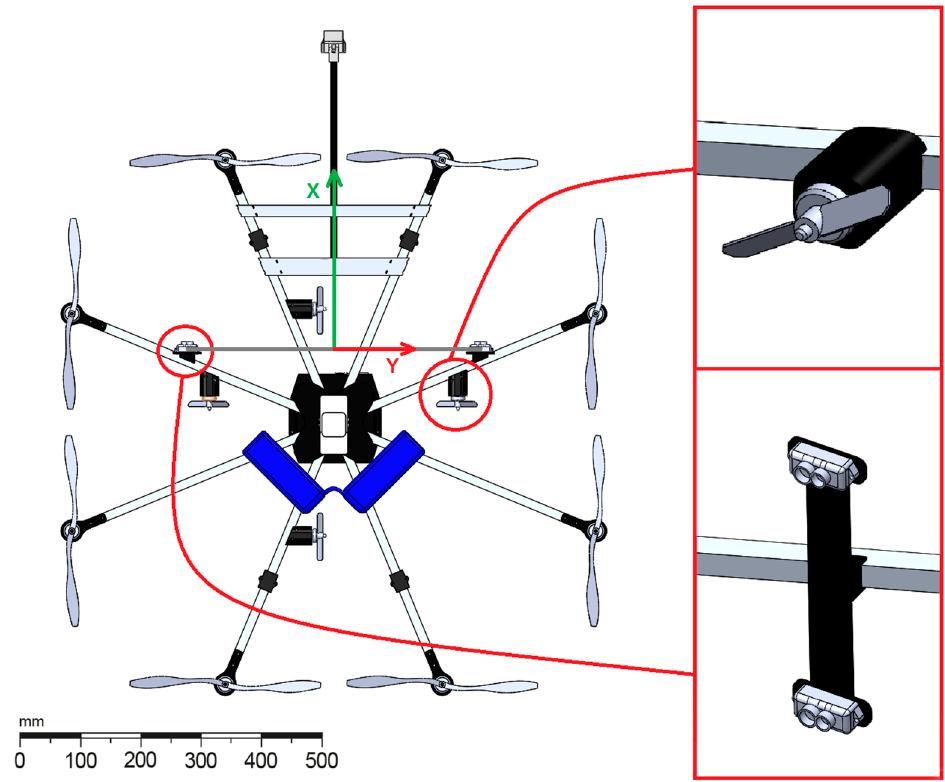
Figure 3. Placement of the LIDAR sensors and the horizontal movement hardware on the UAV platform.